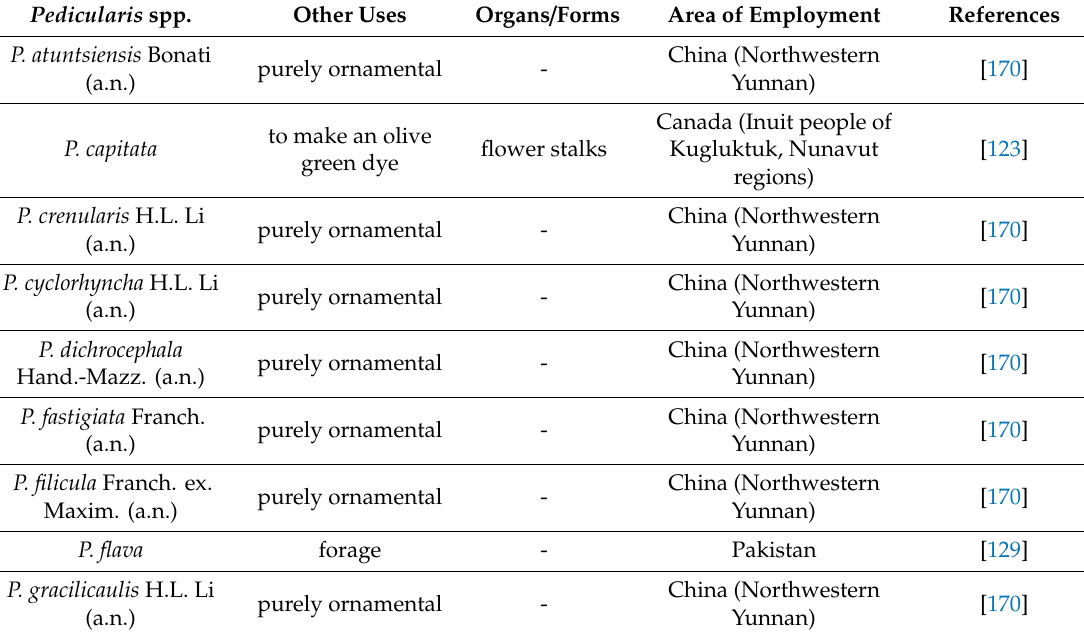
Table 5. Other Uses of Pedicularis Species As Reported In